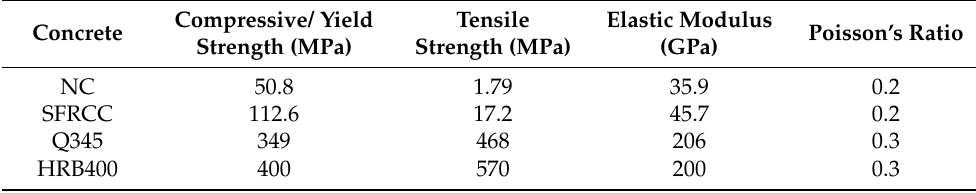
Table 2. Mechanical Properties of